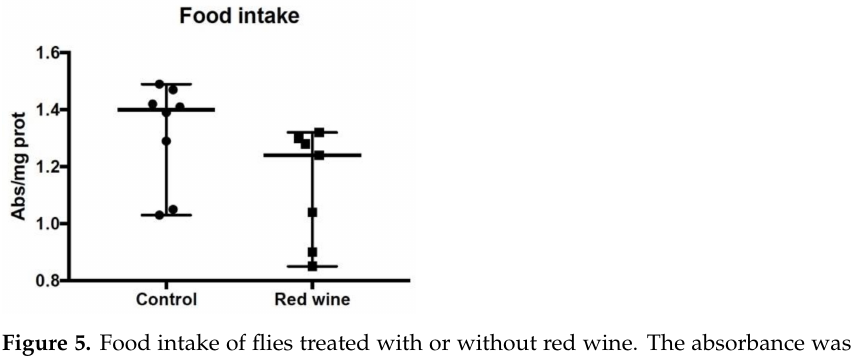
Figure 5. Food intake of flies treated with or without red wine. The absorbance was measured at 625 nanometers (corresponding to the absorption maximum for erioglautia blue). Results are shown as median and range with 95% CI. The differences between the control and the red wine treated groups were not statistically significant ( n = 7–8).